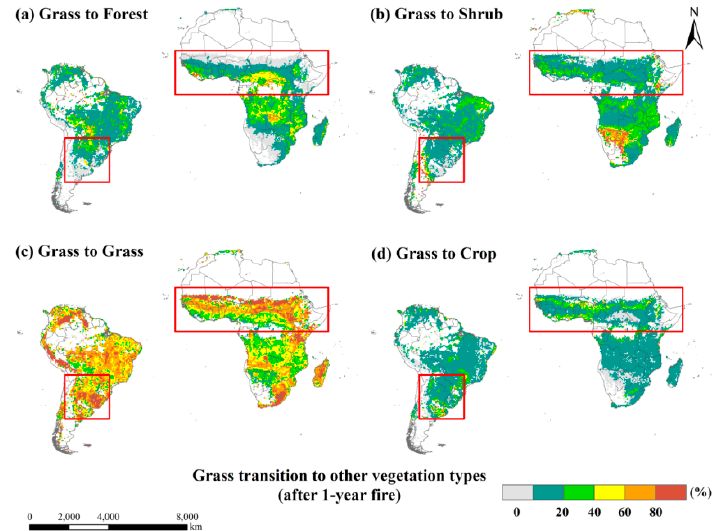
Figure 5. The spatial distribution of vegetation changes in grass regions in the first year after a fire. ( a ) Grass to Forest; ( b ) Grass to Shrub; ( c ) Grass to Grass; ( d ) Grass to Crop. The red rectangles represent the high-density grass (more than 80% of total area in 0.5 ◦ grid cell) in Africa and South America.